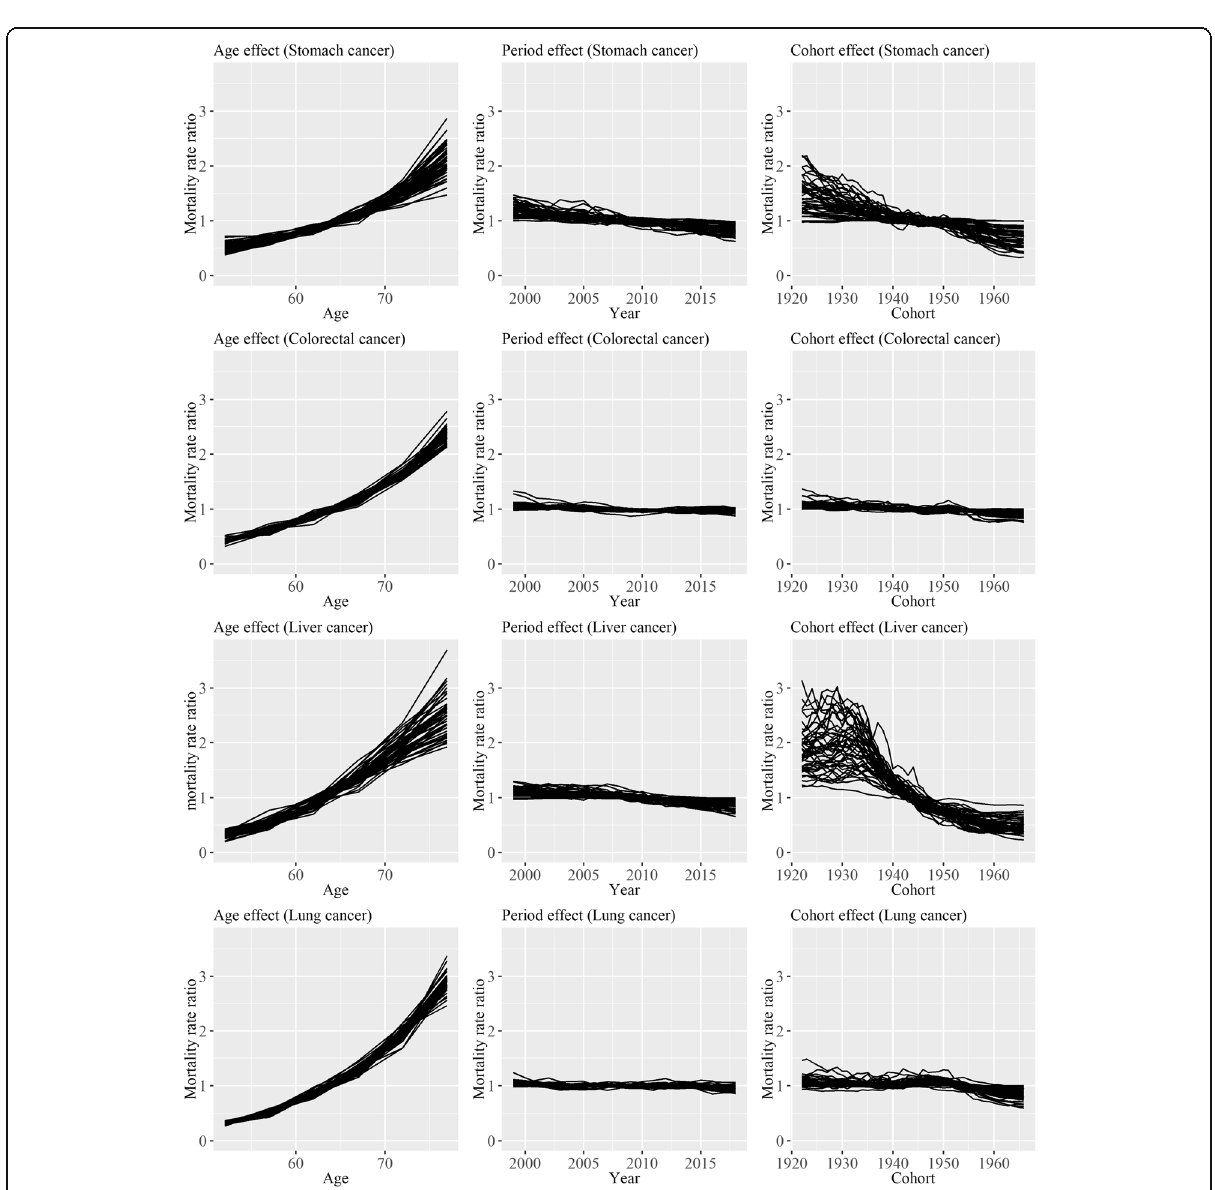
Fig. 2 Age, period, and cohort effects of 47 prefectures for each type of cancer in women. Each line signifies point estimates of each effect for each prefecture, and values of time points in an effect are connected for each prefecture. Regarding age effect, the value for each 5-year age group is assigned to the midpoint of each 5-year age